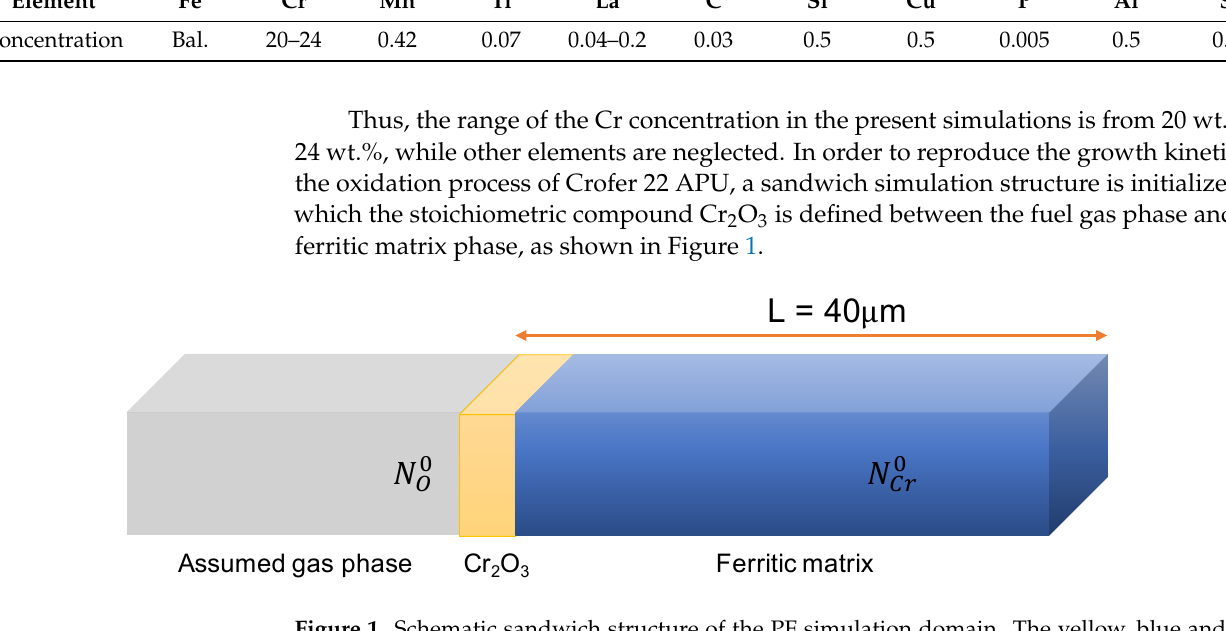
Figure 1. Schematic sandwich structure of the PF simulation domain. The yellow, blue and grey regions are the thin layer of Cr 2 O 3 , the ferritic matrix phase and an assumed gas phase, respectively. The goal of introducing the gas phase region is to provide sufficient oxygen. The mobility of the Cr 2 O 3 /gas interface is set to